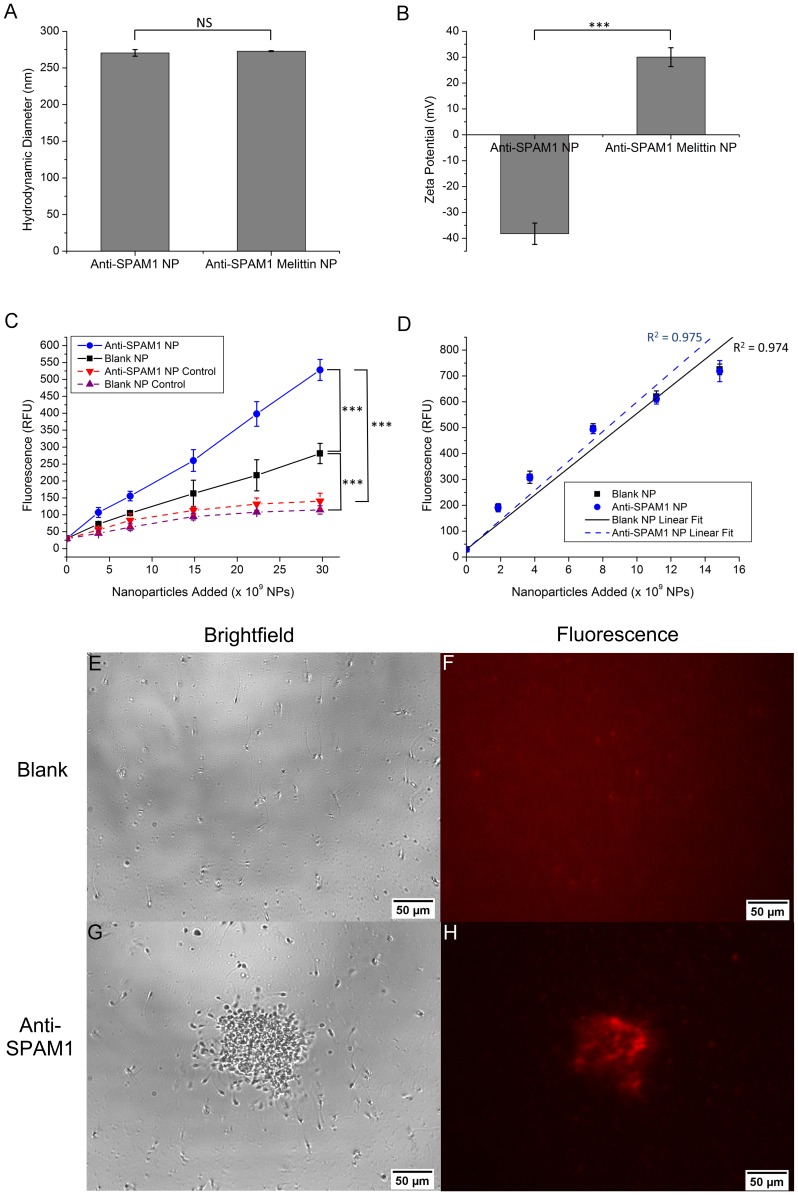
Characterization of SPAM1-targeted NPs and their interactions with sperm.(A and B) Size and zeta potential of anti-SPAM1 NPs and anti-SPAM1-mel-NPs immediately following preparation. (C) Fluorescence of sperm-bound blank NPs and anti-SPAM1 NPs following incubation with sperm for 30 minutes and removal of unbound NPs by density gradient centrifugation. Control samples did not contain sperm and were used to determine background fluorescence due to remaining unbound NPs. (D) Standard curve of blank NP and anti-SPAM1 NP fluorescence used for quantification of sperm binding. Error bars represent S.D. of n = 3 replicates, NS p>0.05, *** p<0.001. (E, F, G and H) Brightfield and fluorescence images of semen samples following addition of 3×1010 blank NPs or anti-SPAM1 NPs. Scale bar = 50 µm.